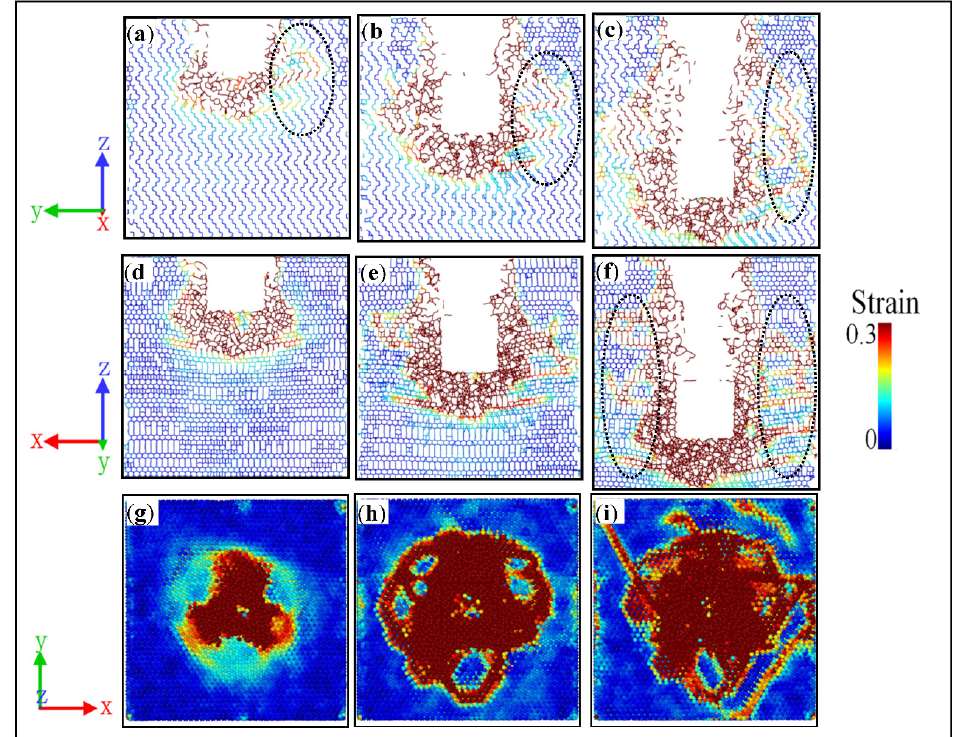
Figure 5. Shear strain nephogram of the 6H-SiC (0001) crystal plane with different indentation depths. ( a ), ( d ) and ( g ) are the shear strain nephograms in different directions when the indentation depth is 3 nm, ( b ), ( e ) and ( h ) are the 6nm indentation depth, ( c ), ( f ) and ( i ) are the 9 nm indentation ( b , e , h ) are the 6nm indentation depth, ( c , f , i ) are the 9 nm indentation depth